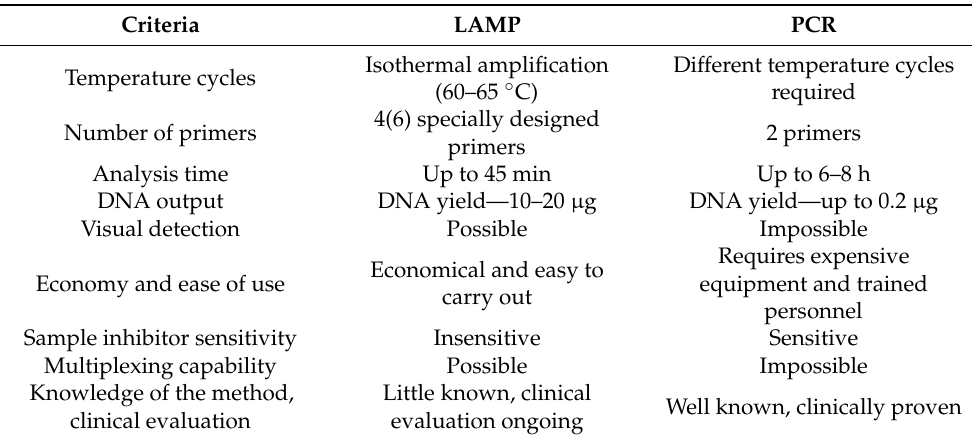
Table 2. Comparison of the methods of loop mediated isothermal amplification (LAMP) and classical polymerase chain reaction